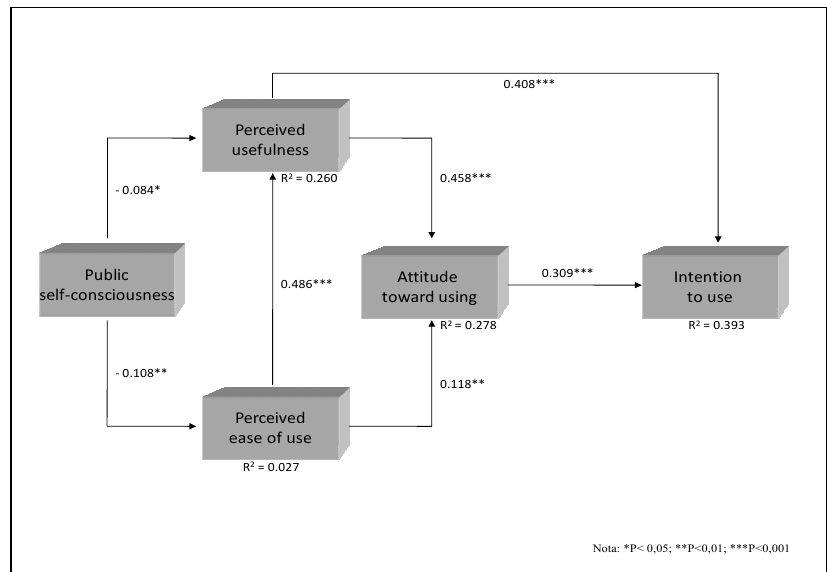
Figure 2. Significant results of the proposed model.